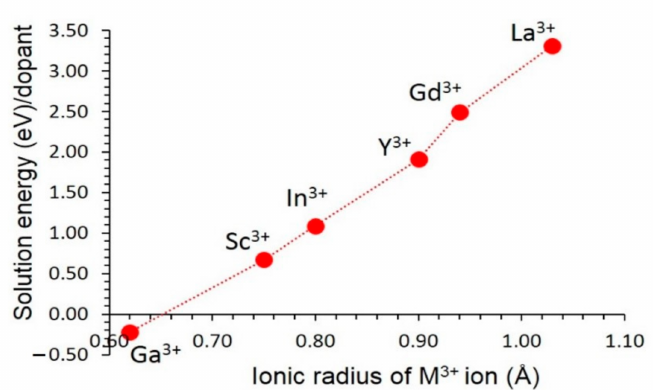
Figure 5. Solution energy of M 2 O 3 (M = Ga, Sc, In, Y, Gd, and La) with respect to the M 3+ ionic